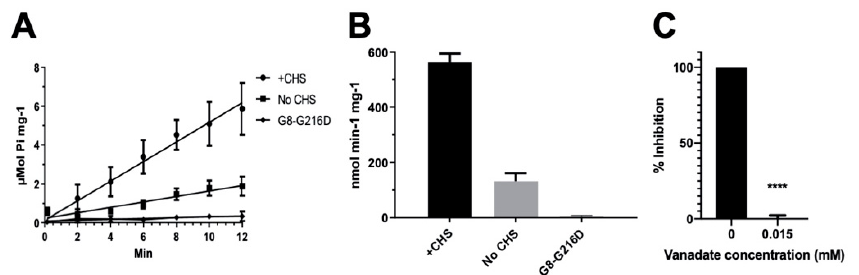
Figure 3. ATPase activity of ABCG5 / G8. The ATP hydrolysis was used as a measure of ABCG5 / G8 ATPase activity at 37 ◦ C in conditions with 5 mM ATP and 4.1 mM CHS. The protocol is entailed in Section 4. ( A ) Data points are presented as the means ± standard deviations from 4–8 independent experiments using 2–4 independently purified proteins; where not visible, the error bars are covered by the plot symbols. A linear regression, plotted from the first 12 min, is used to calculate the specific activities. ( B ) Bar graphs show the specific activities of ATP hydrolysis by wild type (WT) in the presence and absence of CHS and the catalytically deficient mutant G8-G216D in the presence of CHS. The specific activity of WT in the absence of CHS is regarded as the basal ABCG5 / G8 ATPase activity. ( C ) Bar graphs represent the percentage inhibition of ABCG5 / G8 ATPase activity by 0.015 mM orthovanadate, where a p -value of < 0.0001 (marked as ****) was obtained using ordinary one-way ANOVA (Prism 8).